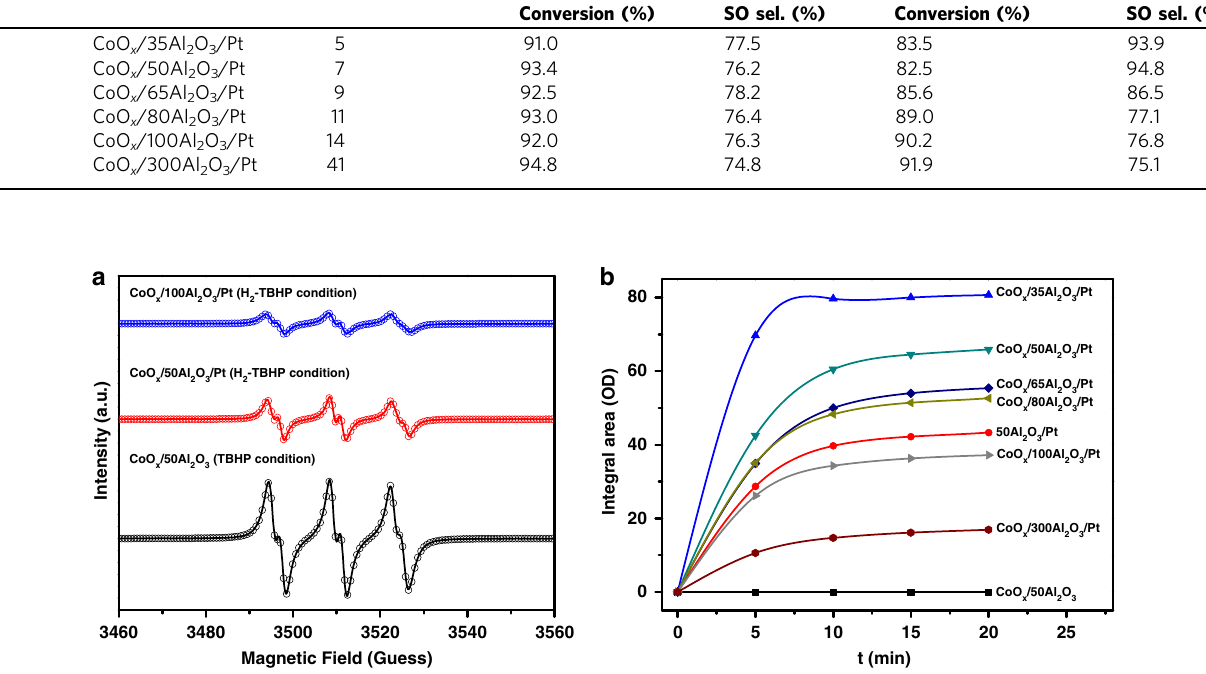
Fig. 5 Catalytic mechanism analyses. a Experimental EPR spectra (lines) and simulated spectra (open circles) for a mixture of PBN – OOC(CH 3 ) 3 and PBN – OC(CH 3 ) 3 . b Intensity of the ʋ (OD) band during exposure of samples in (D 2 :H 2 = 1:1) at a total D 2 /H 2 fl ow rate of 30 ml min − 1 at 80 °C and 1